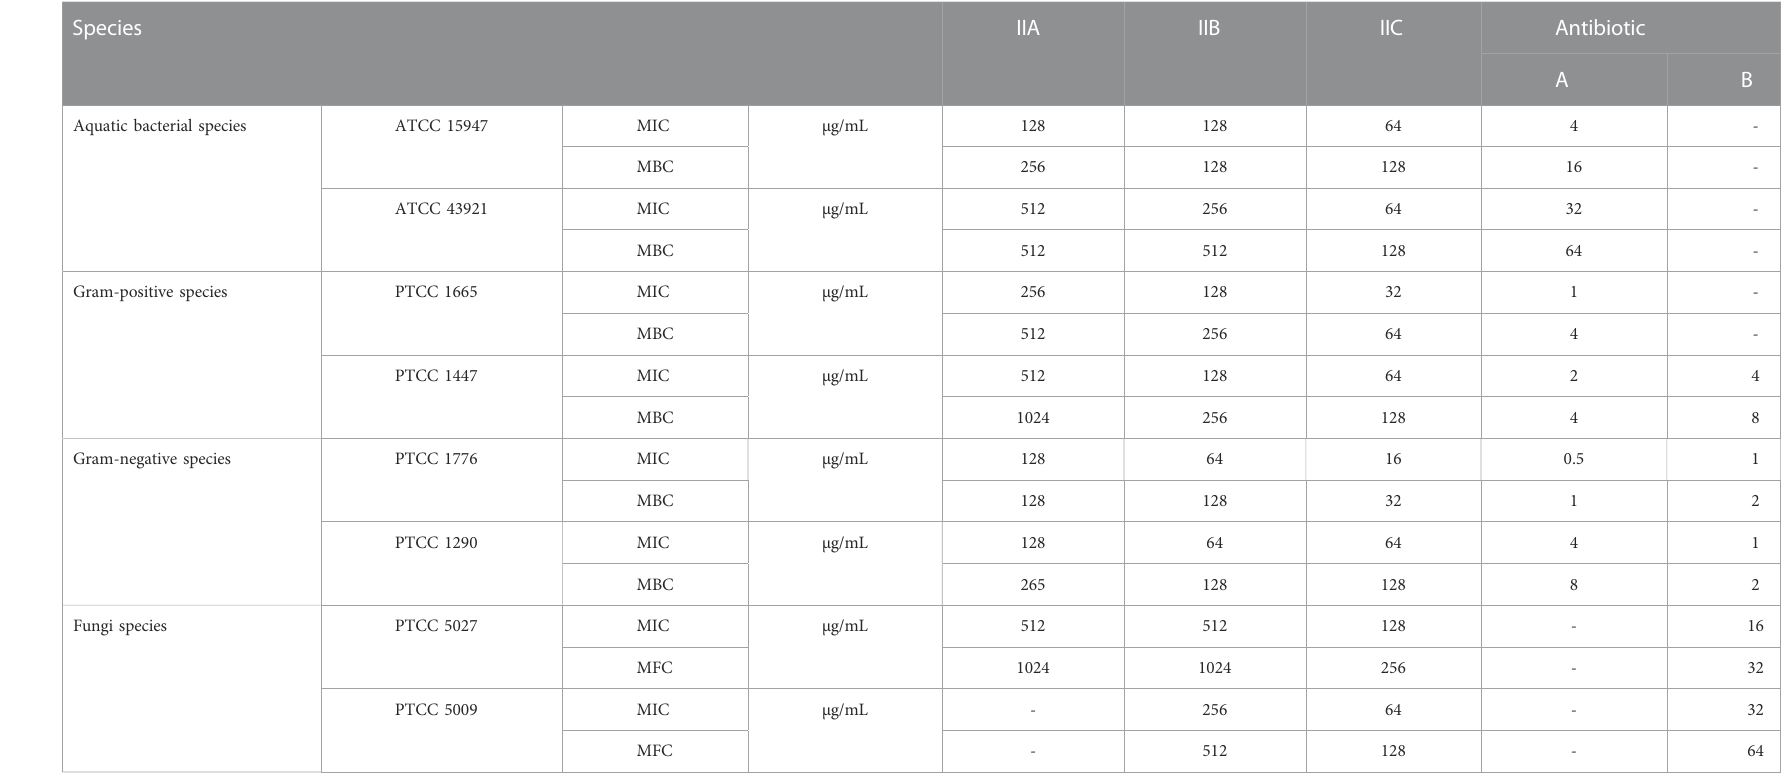
Aquatic bacterial species